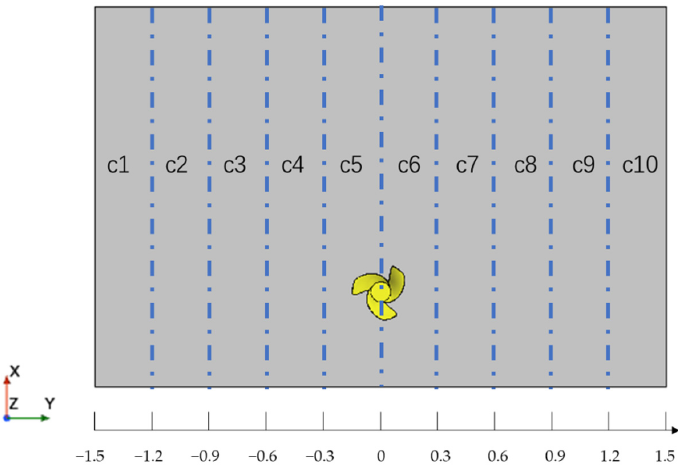
Figure 22. Regions of flow field divided along the lateral direction.